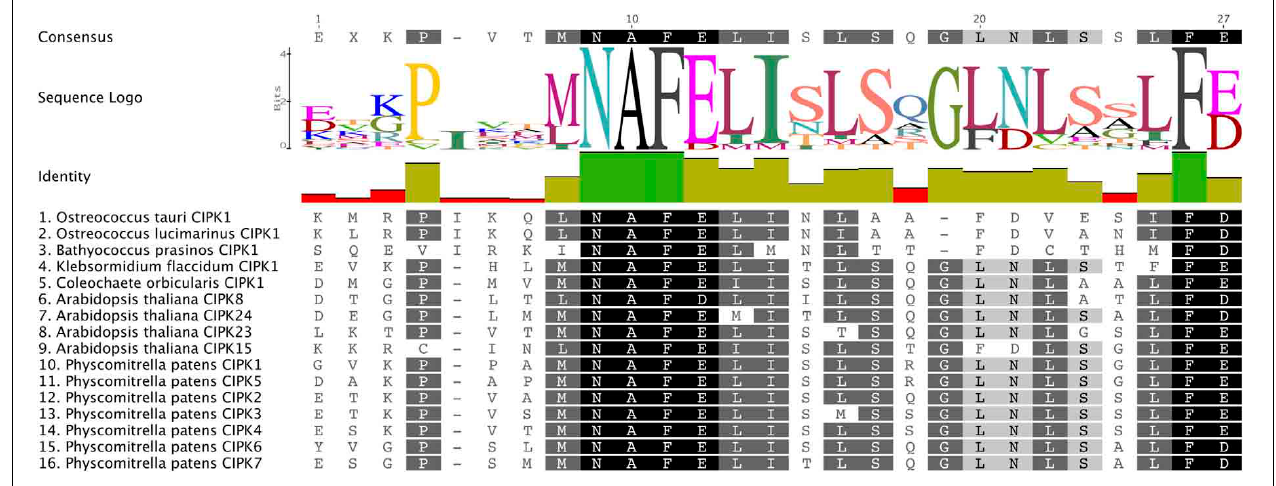
FIGURE 6 | The CBL-interacting or NAF motif is conserved in green algal and moss CIPKs. Consensus amino acid sequence of this motif and degree conservation, illustrated by bar graph, are provided above the MSA, which is shaded based on the degree of